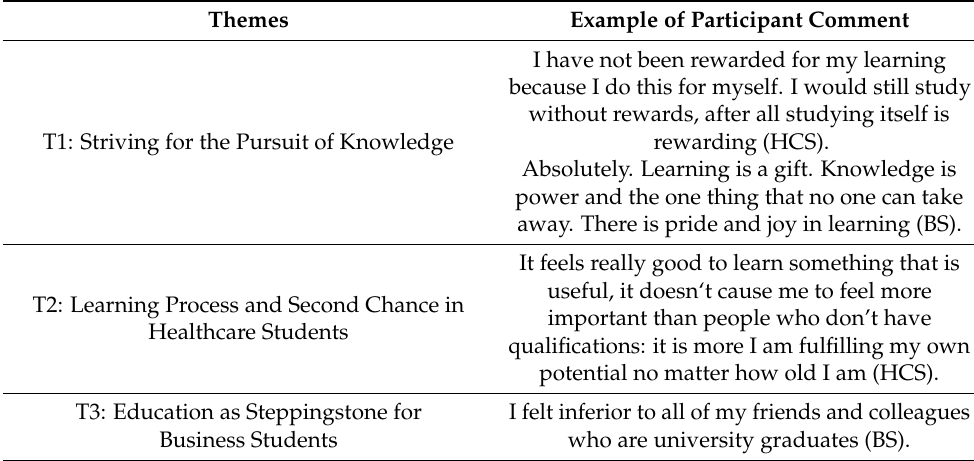
Table 3. Themes and examples of participant